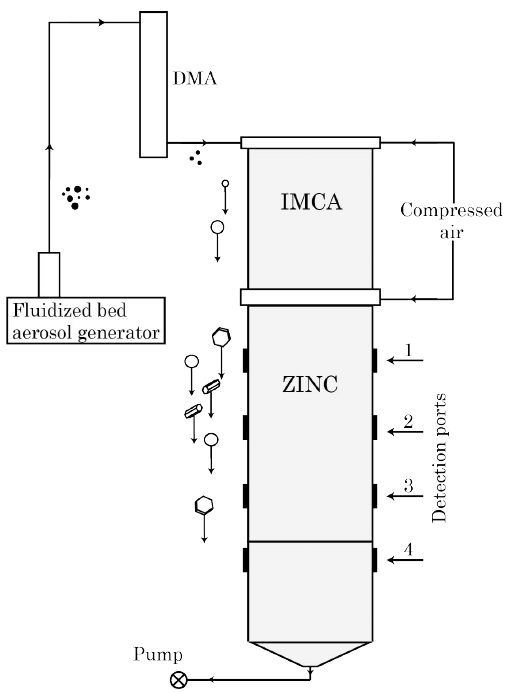
Fig. 1. Schematic of the experimental setup. A fluidized bed aerosol generator is used to produce mineral dust aerosol. Particles with 400nm and 800nm diameter are selected with a DMA. In the top of IMCA particles activate as CCN at 300K before they are contin- uously cooled down to the freezing temperature prevailing in ZINC. In the transition from IMCA to ZINC additional sheath air is intro- duced to counteract buoyant displacement of the droplets from the centre position. In ZINC the droplets are exposed to cold temper- atures and eventually the immersed particles cause the droplets to freeze. The time-dependent frozen fraction is detected with IODE consecutively at the four detection